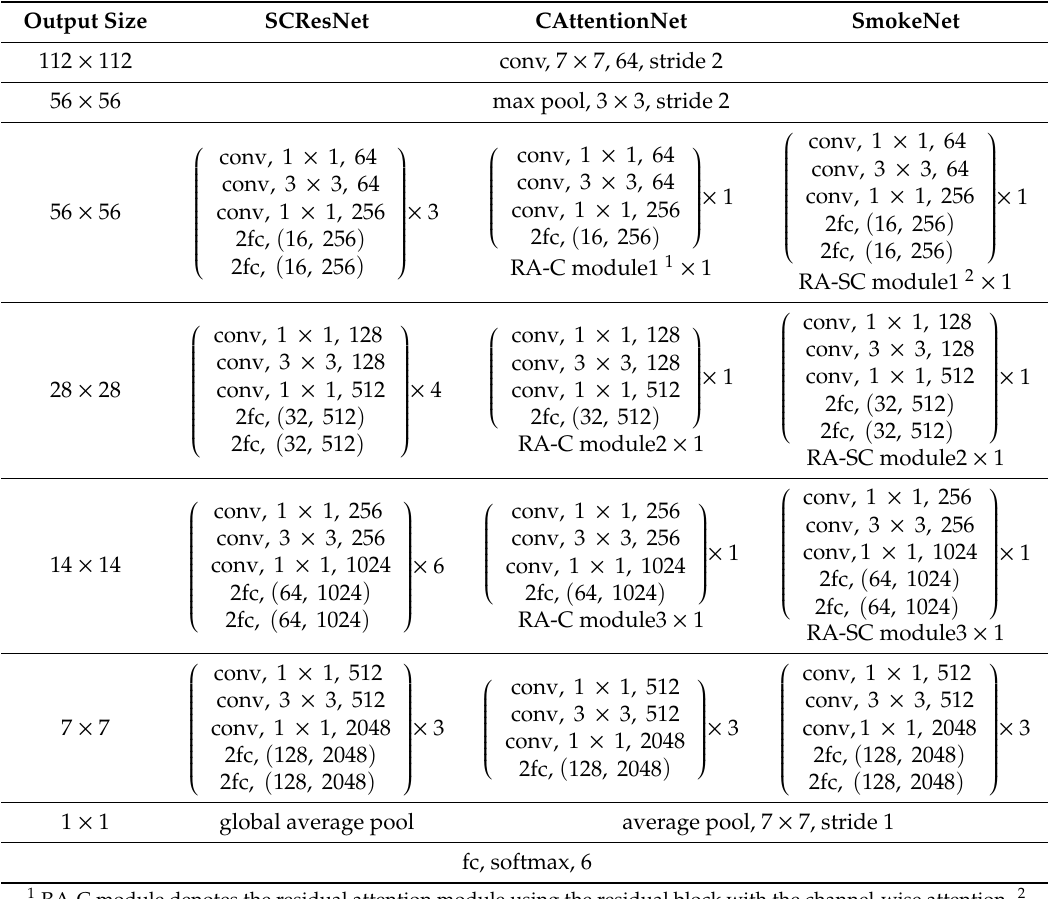
Table 3. Structure details of the SCResNet, CAttentionNet, and proposed SmokeNet models.